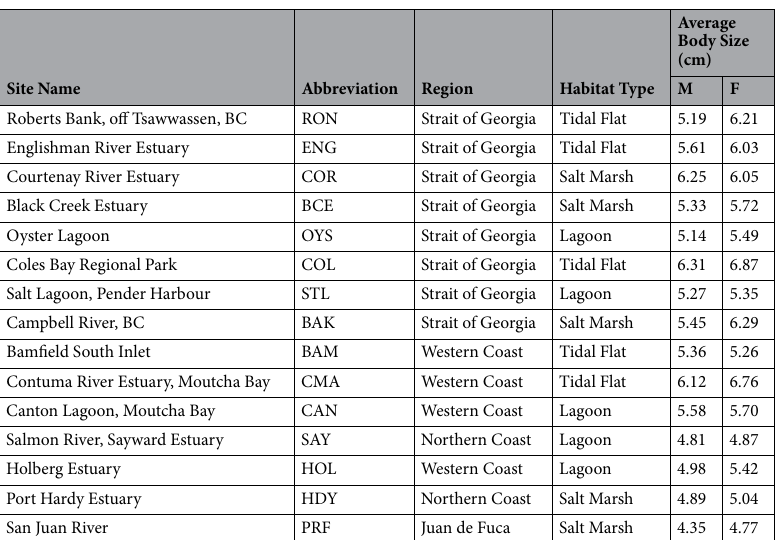
Table 1. List of sites including each respective site abbreviation, region around Vancouver Island, the habitat type, and the average body size of sticklebacks between males (M) and females (F).